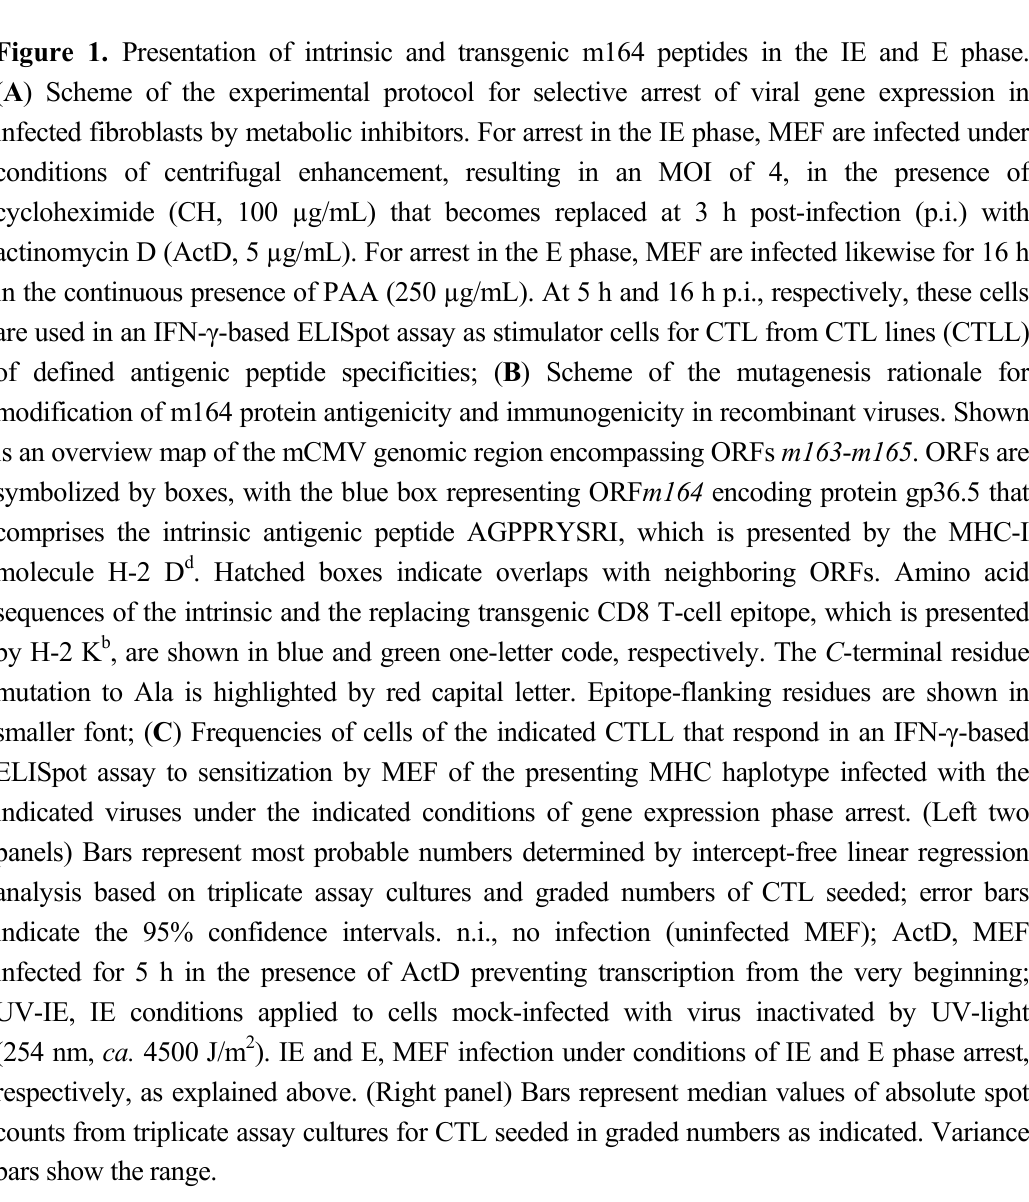
Figure 1. Presentation of intrinsic and transgenic m164 peptides in the IE and E phase. ( A ) Scheme of the experimental protocol for selective arrest of viral gene expression in